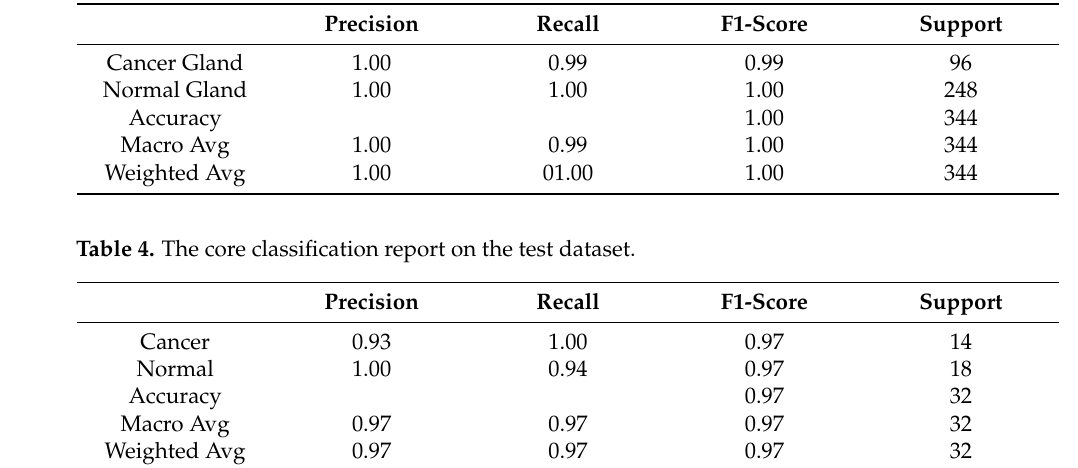
Table 3. The gland classification report on the test dataset.